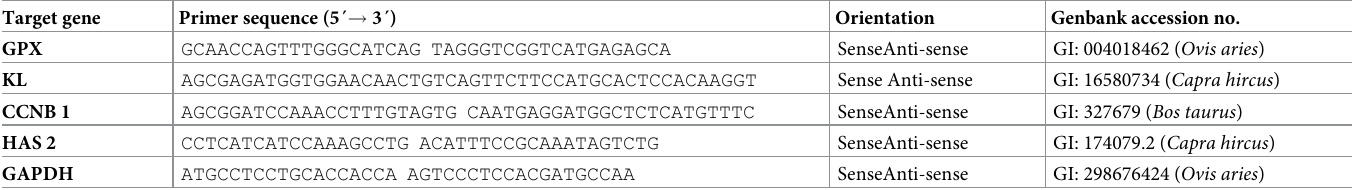
Table 1. Oligonucleotide primers used for polymerase chain reaction analysis. Target